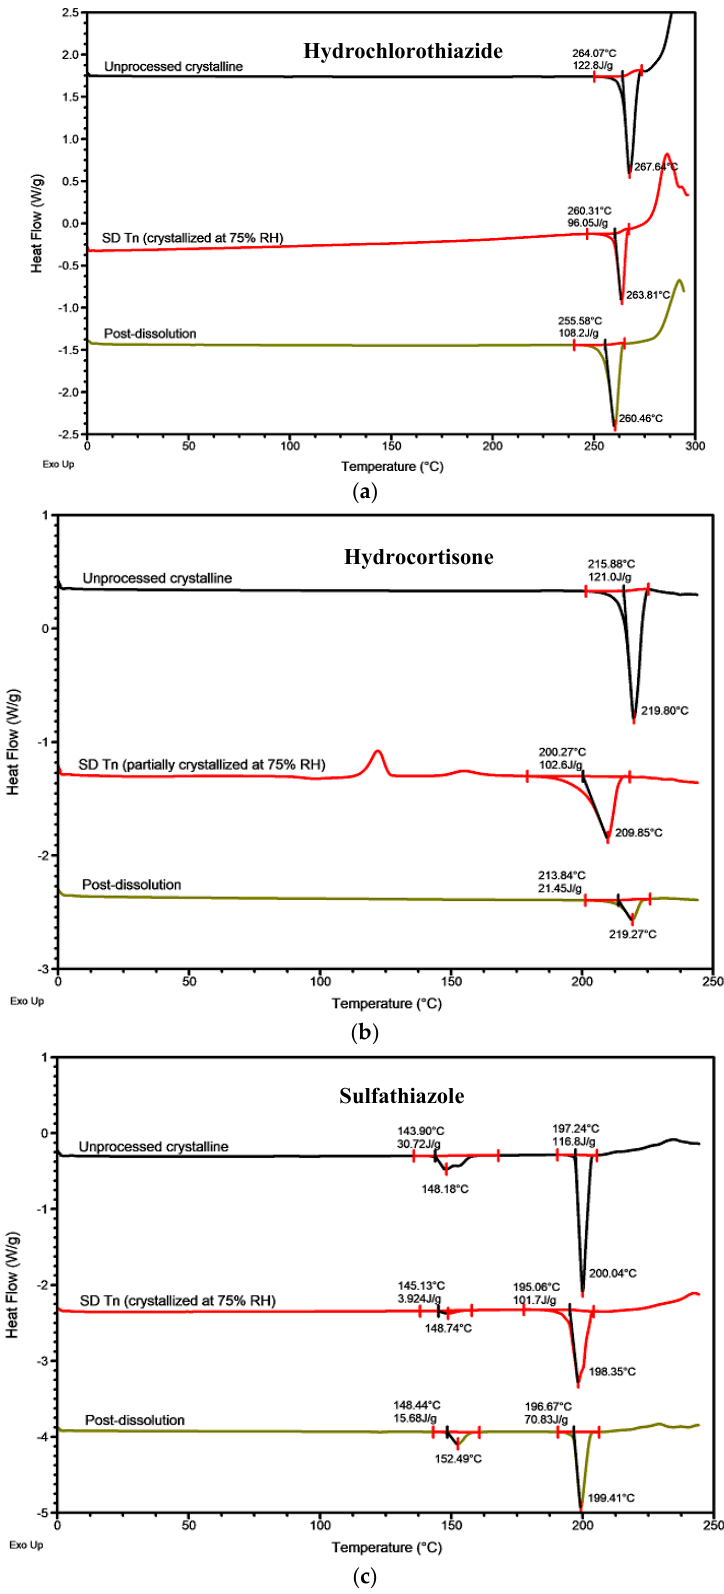
Figure7. Thedifferentialscanningcalorimetrythermogramsof( a )hydrochlorothiazide,( b )hydrocortisone, and ( c ) sulfathiazole. For each API, the thermograms of unprocessed crystalline API, spray-dried samples stored at 75% RH, SD T n (partially, or completely crystallized), and post-dissolution solid samples are shown. A representative of duplicate runs is shown for each sample